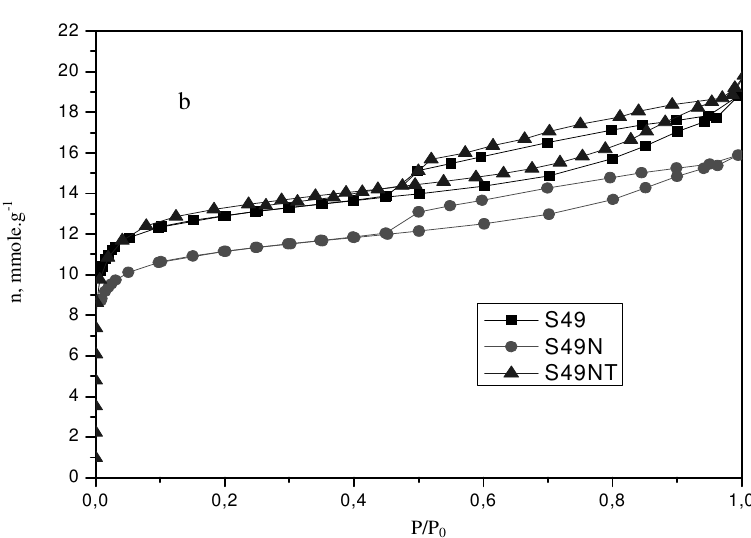
Figure 2. N adsorption desorption isotherms at 77 K for (a) C50 and (b) S49 carbons as 2 prepared, after an oxidation treatment with HNO N at 973 K 2 Table 1 . Specific surface area and pore volume calculated from the N isotherms at 77 K and 273 K, respectively, for the different activated carbons after treatments